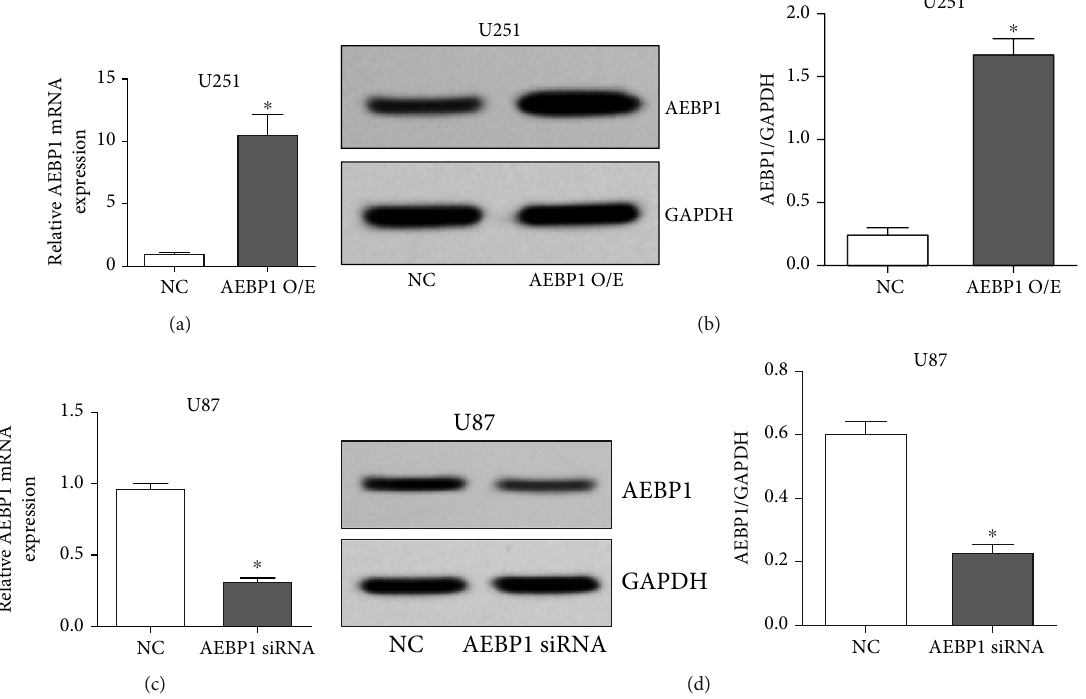
Figure 3: Validation of AEBP1 overexpression and silencing in GBM cells. Transfection of the AEBP1 overexpression plasmid in U251 cells and AEBP1 siRNA in U87 cells: (a, c) detection of AEBP1 mRNA expression by qRT-PCR; (b, d) detection of AEBP1 protein expression by western blot. N = 3 , ∗ P < 0 : 05